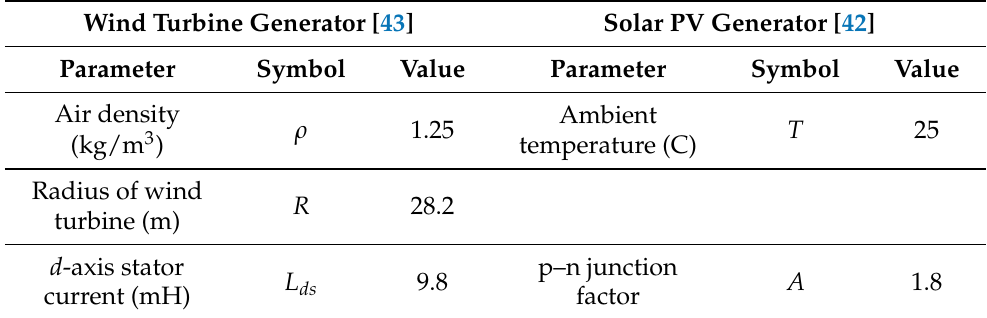
Table 1. Parameters of the renewable generation